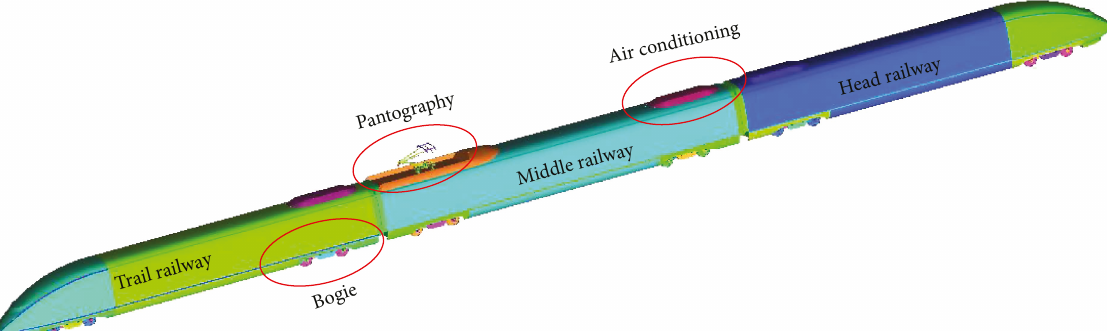
Figure 1: Numerical model of CRH3 high-speed railways.